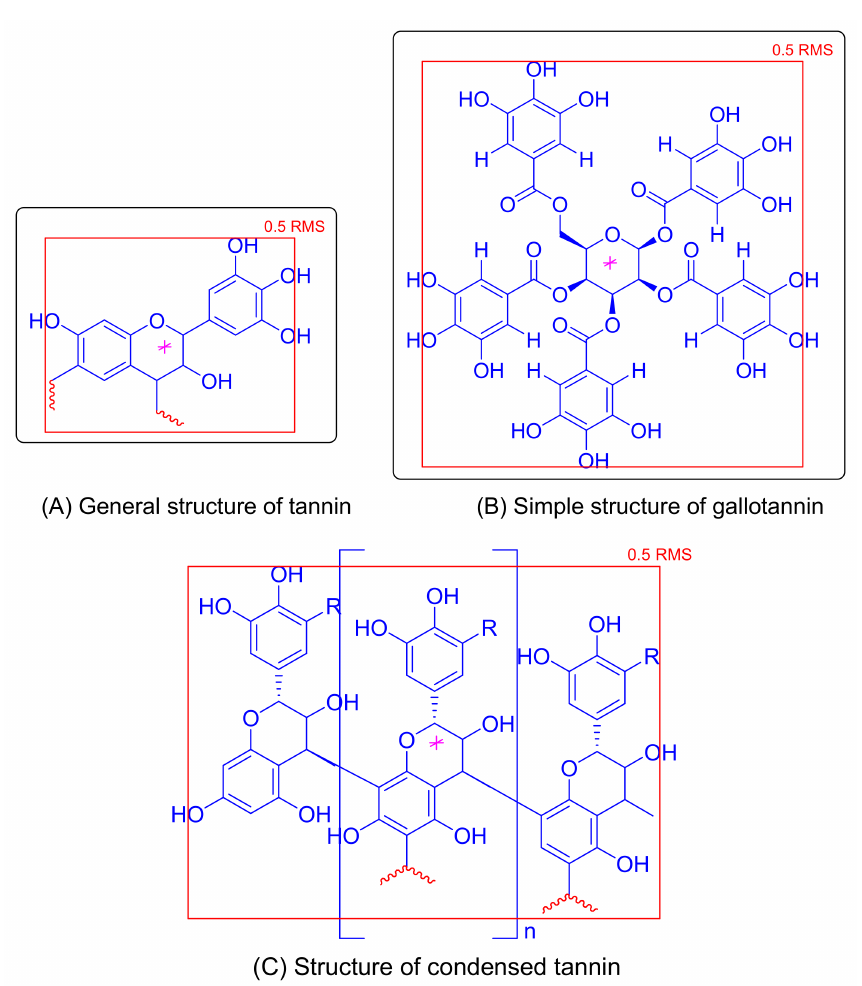
Figure 1. Structures of tannins [16]: ( A ) general structure of tannin; ( B ) simple structure of gallotannin; ( C ) structure of condensed